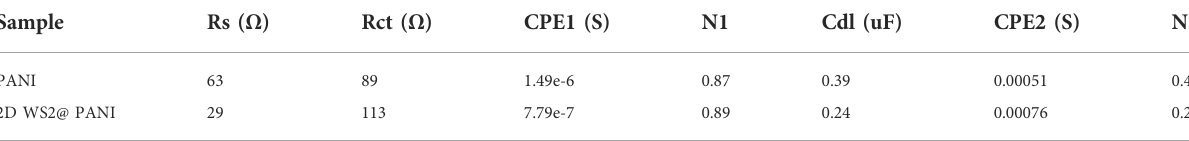
TABLE 3 Fitted values from the EIS characterization of the NaCh-based 1:20 2D WS 2 @PANI nanohybrid and for pure PANI after GCD analysis.